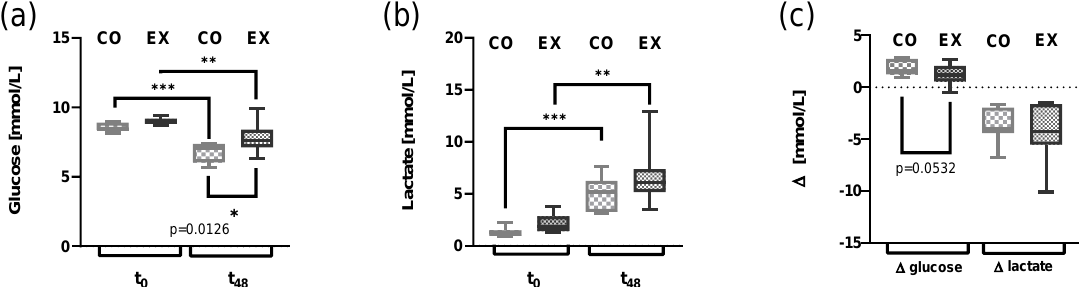
Figure 3. Changes in lactate and glucose levels after 48 h of cell culture following incubation of CD4+ T cells from cohort 2 with 50% control serum (CO) or exercise serum (EX). T cells were activated with anti-CD3/anti-CD28. Glucose level ( a ), lactate level ( b ), and changes ( ∆ ) before to after cell culture ( c ) are shown as box and whiskers min to max ( n = 7 per group), ( a , b ) two-way ANOVA followed by multiple comparisons; ( c ) Student’s t -test * p < 0.05, ** p < 0.01, *** p < 0.001. ANOVA: analysis of the variance.